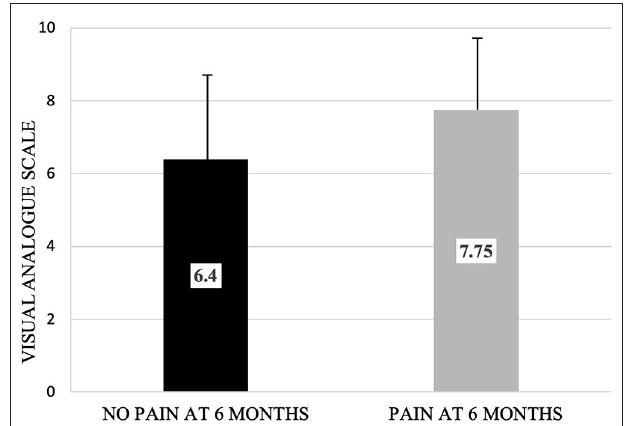
FIGURE 1 | Preoperative pain level of cohort with no neuropathic pain at 6 months post-surgery visit and cohort with neuropathic pain at 6 months post-surgery visit as measured by visual analog scale. Bars depict upper limit of standard deviation (No pain: 2.68; Pain: 1.95). There was a statistically significant difference in preoperative pain level between the two groups ( p =